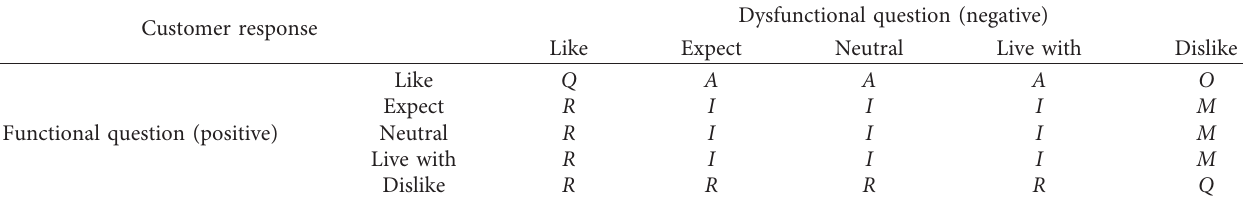
Table 1: Kano’s form. Depending on the user response, the category of the attribute can be predicted. These are the categories: must-be ( M ), one-dimensional ( O ), attractive ( A ), indifferent ( I ), reverse ( R ), and questionable ( Q ) (cannot predict the category of the attribute).